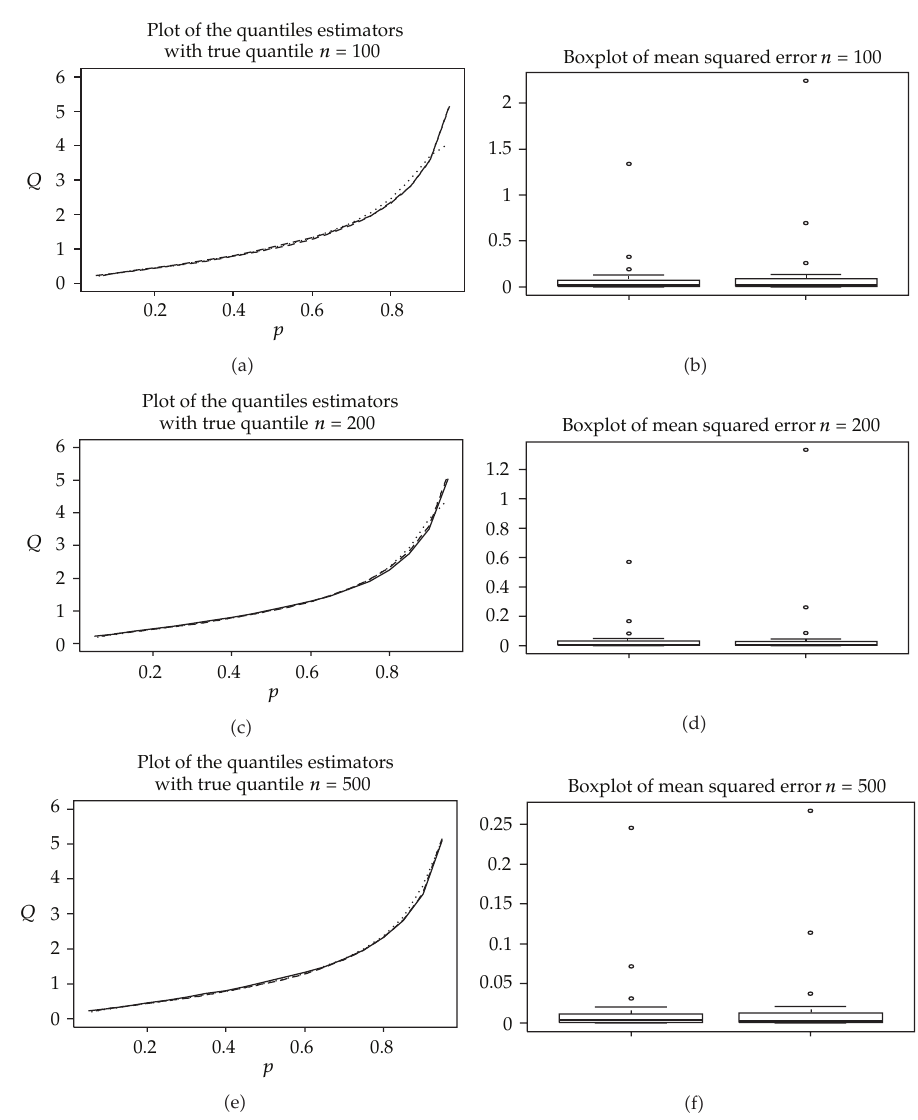
Figure 3: Left panel: plots of the quantile estimators for method 1 (cid:4) solid line (cid:5) , method 2 (cid:4) dotted line (cid:5) and true quantile (cid:4) dashed line (cid:5) for di ff erent sample sizes and for data from a Log-normal distribution. Right panel: box plots of mean squared errors for the quantile estimators for method 1 and method 2 for di ff erent sample